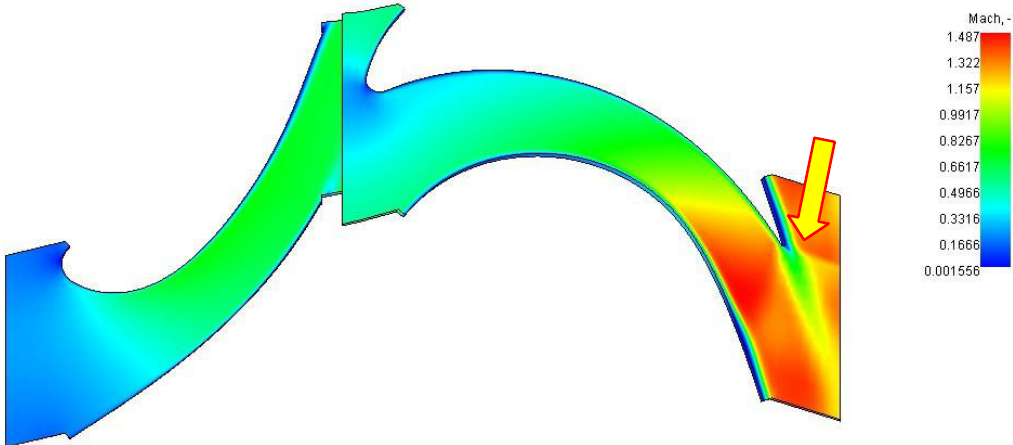
Figure 30. Mach number contours for the 28% spanwise section of the turbine.